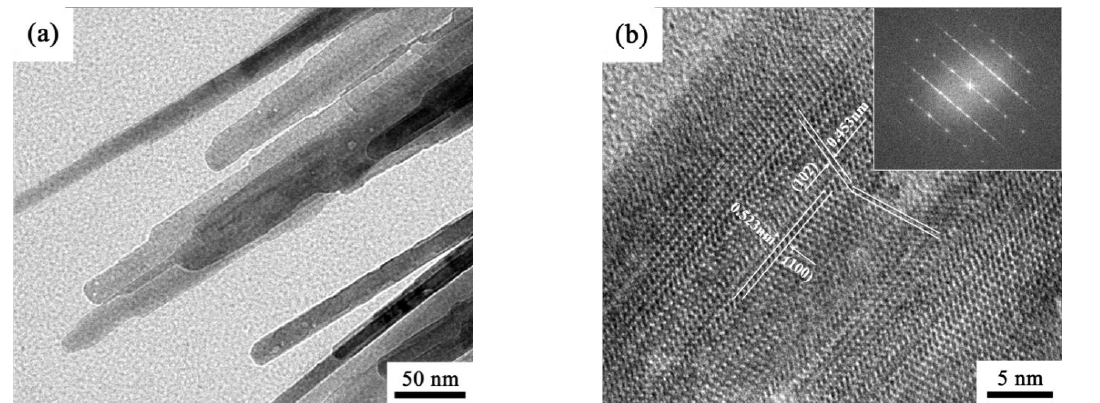
Figure 5. High resolution transmission electron microscope (HRTEM) images of θ-Al 2 O 3 whiskers prepared by the hydrothermal method with the molar ratio of Al 3+ :CO(NH 2 ) 2 of 1:6 followed by annealing at 1000 °C: ( a ) tips of whiskers and ( b ) twins. Inset image in Figure ( b ) shows the selected area electron diffraction (SAED) pattern of twins.